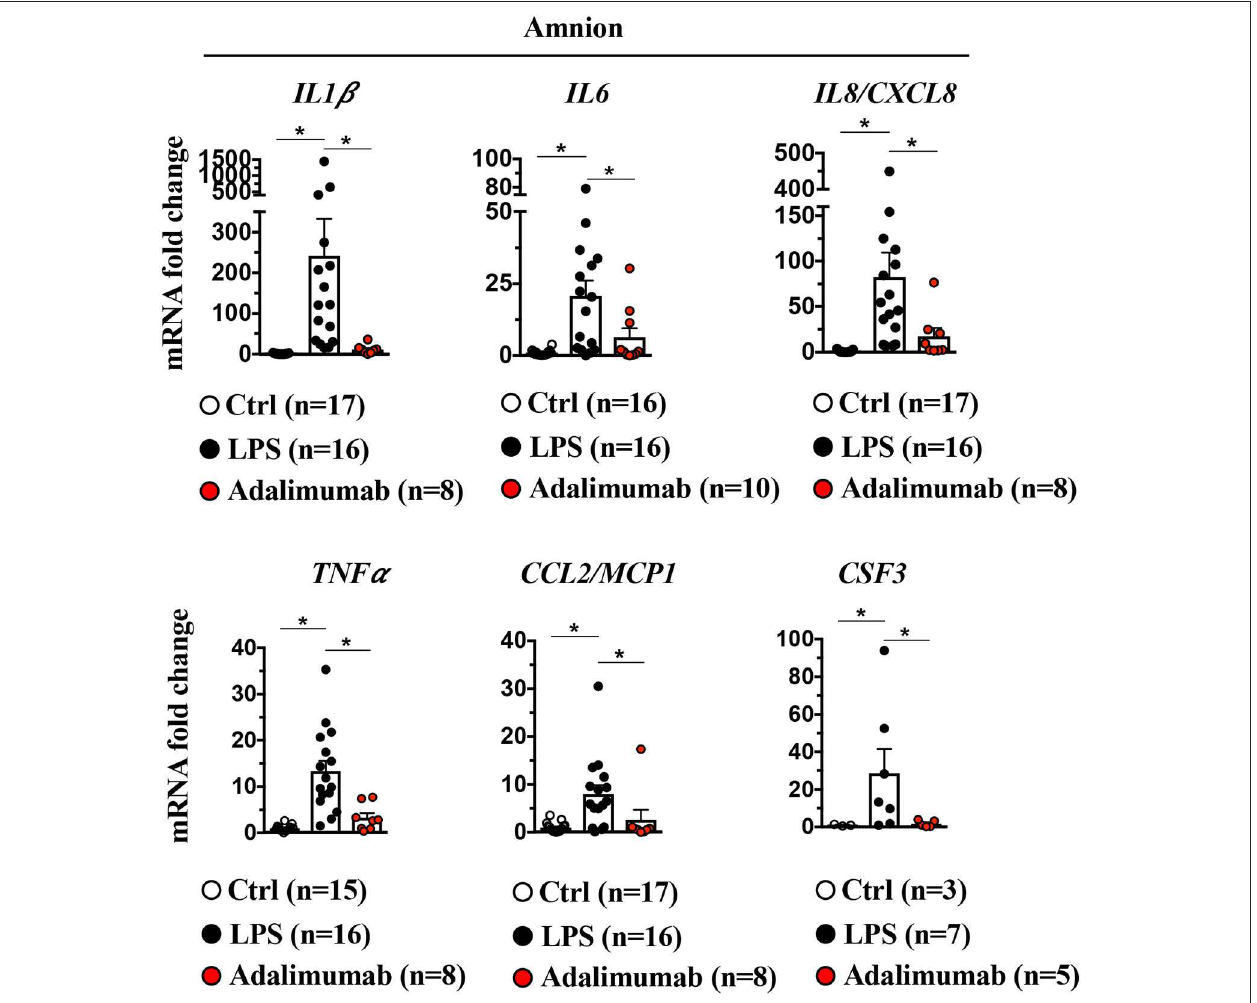
FIGURE 6 | Signaling in amnion: Induction of LPS-induced pro-inflammatory cytokines and neutrophil chemoattractant is TNF-dependent. Amnion was physically separated from chorion and decidua parietalis, and expression of cytokine mRNAs by quantitative PCR (Taqman probes) is shown. Intraamniotic LPS induced IL1 β , IL6, IL8/CXCL8 TNF α , CCL2/MCP1, and CSF3. All LPS-induced cytokine/chemokine mRNAs were inhibited by Adalimumab. Average mRNA values are fold increases over the average value for control after internally normalizing to the housekeeping 18S RNA (Ctrl n = 3–17; LPS n = 7–16; Adalimumab n = 5–10). Data are mean ± SEM, * p < 0.05 between comparators (Mann–Whitney U -test).